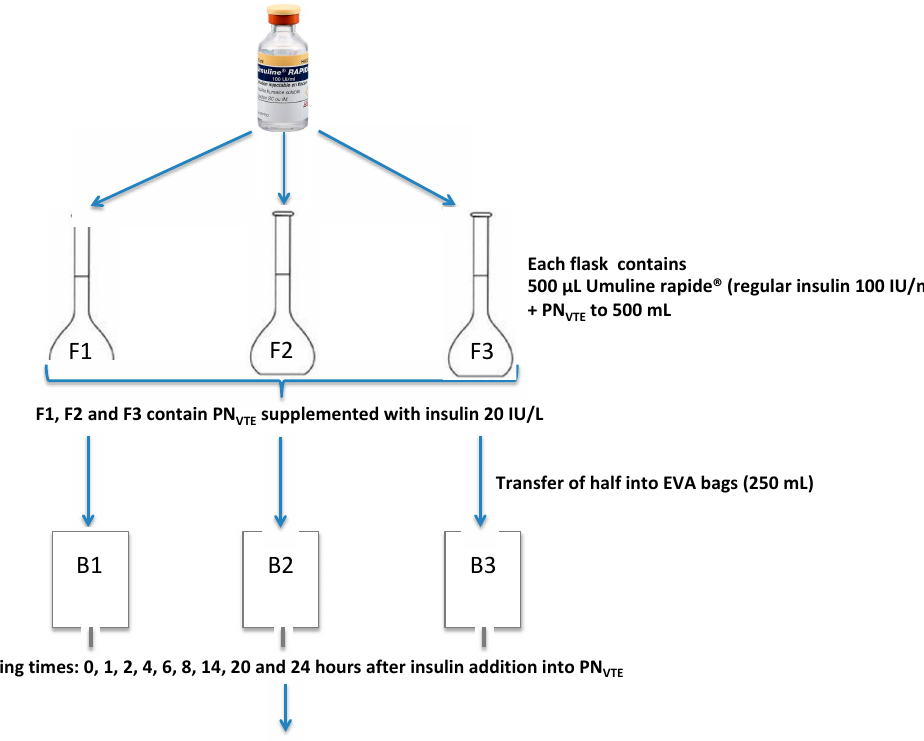
Figure 1. Stability study design. PN VTE : parenteral nutrition supplemented with vitamins and trace elements; F: glass flask; B: Ethylene Vinyl Acetate (EVA) bag; BSA: bovine serum albumin. Addition of insulin at a final concentration of 20 IU/L in different PN media. Final PN admixture containing insulin was divided into two equal volumes in order to perform the assay in both glass flasks and EVA bags.